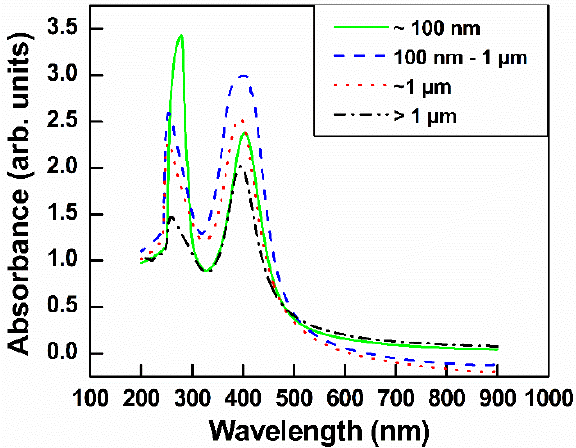
Figure 5. UV-visible spectra of GO–Ag NPs with various sizes GO.